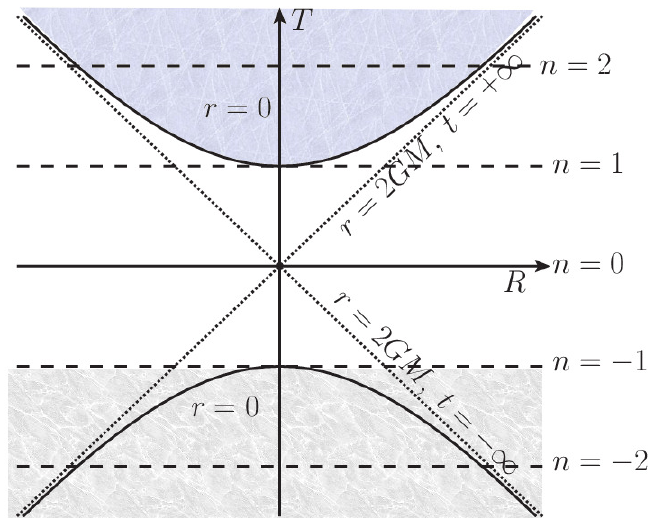
Figure 1. The Exotic Kruskal spacetime diagram with complex radial coordinate. The darkened region T < − 1 is absent due to a dimensional reduction in these two coordinates-the spacetime is simply a 2-sphere